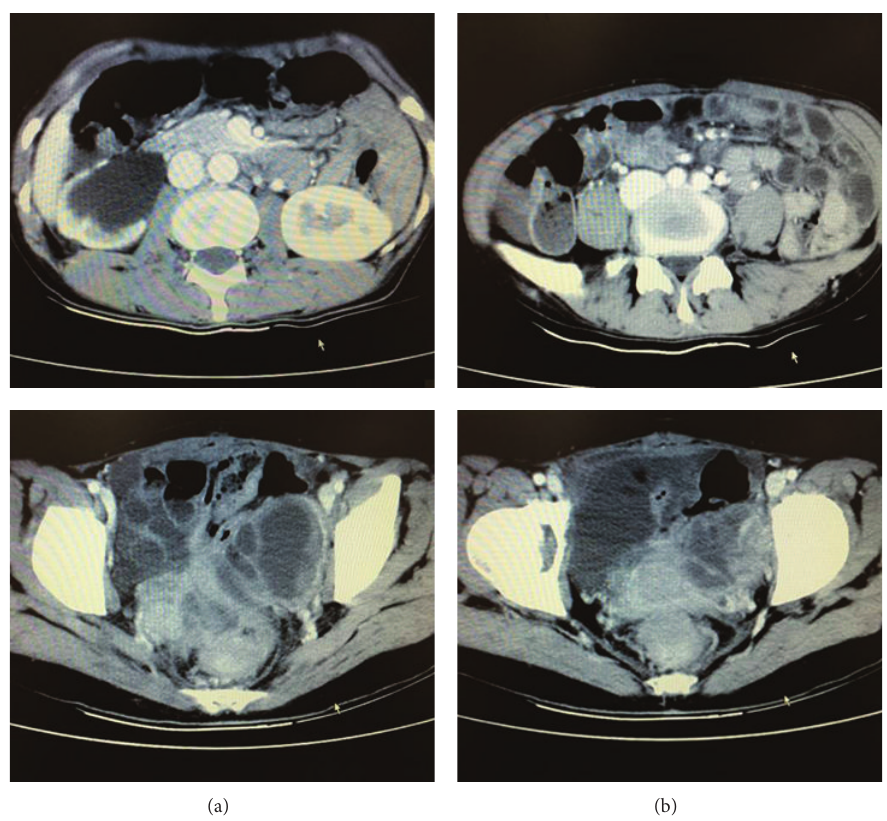
Figure 1: Abdominal and pelvic computed tomographic scan demonstrated thickening of rectal wall with inhomogeneous enhancement and a 4cm soft tissue mass that involved the rectum and left ovary. Right hydronephrosis and hydroureter were also